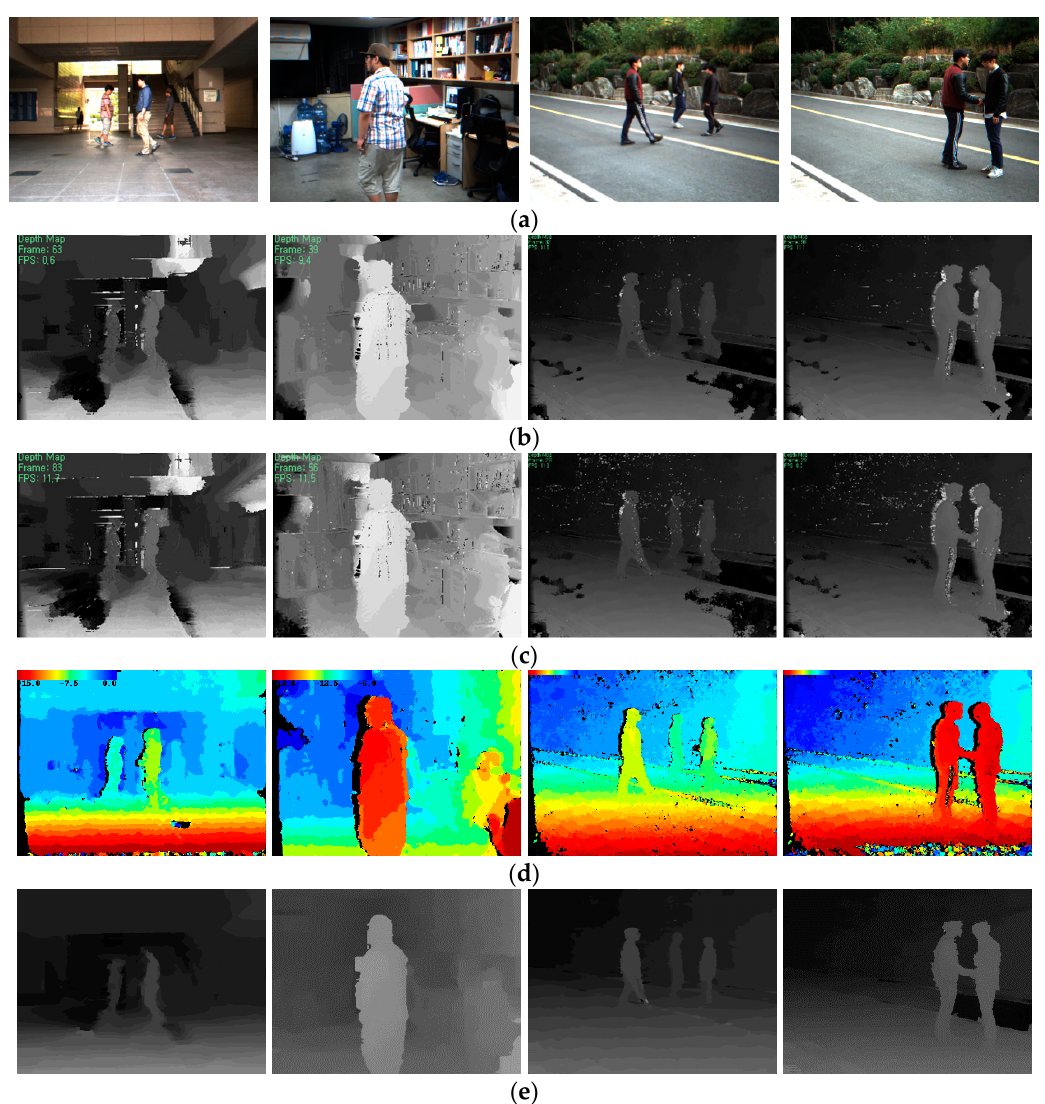
Figure 9. ( a ) Outdoor and indoor scene images; Disparity maps produced by ( b ) DCB grid [23]; ( c ) adaptive weight [21]; ( d ) MGM [24]; and ( e ) proposed method.